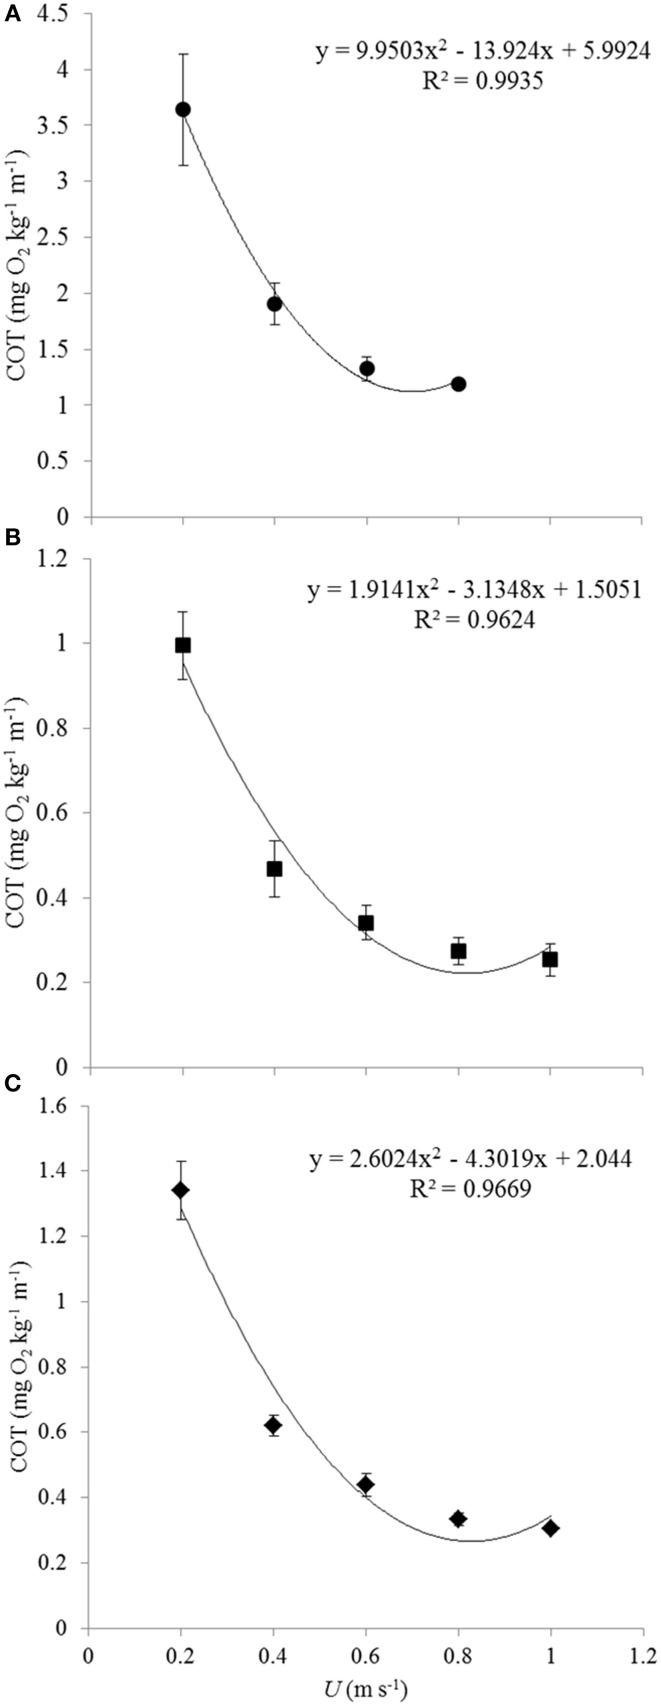
Average COT values for each of the three size groups and polynomial plotting of trend-lines. Each of the graphs representing the subsequent size groups gives the polynomial relation between COT and U and the R2-value. Averages and standard errors are based on data of decreasing numbers of fish for increasing speeds because of fish fatiguing and because of rejecting data of fish that were utilizing the lower flows near the wall of the swim-tunnel: (A) 0.20 m s−1: n = 7; 0.40 m s−1: n = 7; 0.60 m s−1: n = 6; 0.80 m s−1: n = 2, (B) 0.20 m s−1: n = 5; 0.40 m s−1: n = 8; 0.60 m s−1: n = 8; 0.80 m s−1: n = 7; 1.00 m s−1: n = 6, (C) 0.20 m s−1: n = 7; 0.40 m s−1: n = 7; 0.60 m s−1: n = 7; 0.80 m s−1: n = 6; 1.00 m s−1: n = 5. COT values of the smaller fish of group 1 were generally much higher than those of groups 2 and 3. Individual variation in COT decreased at increasing swimming speeds.